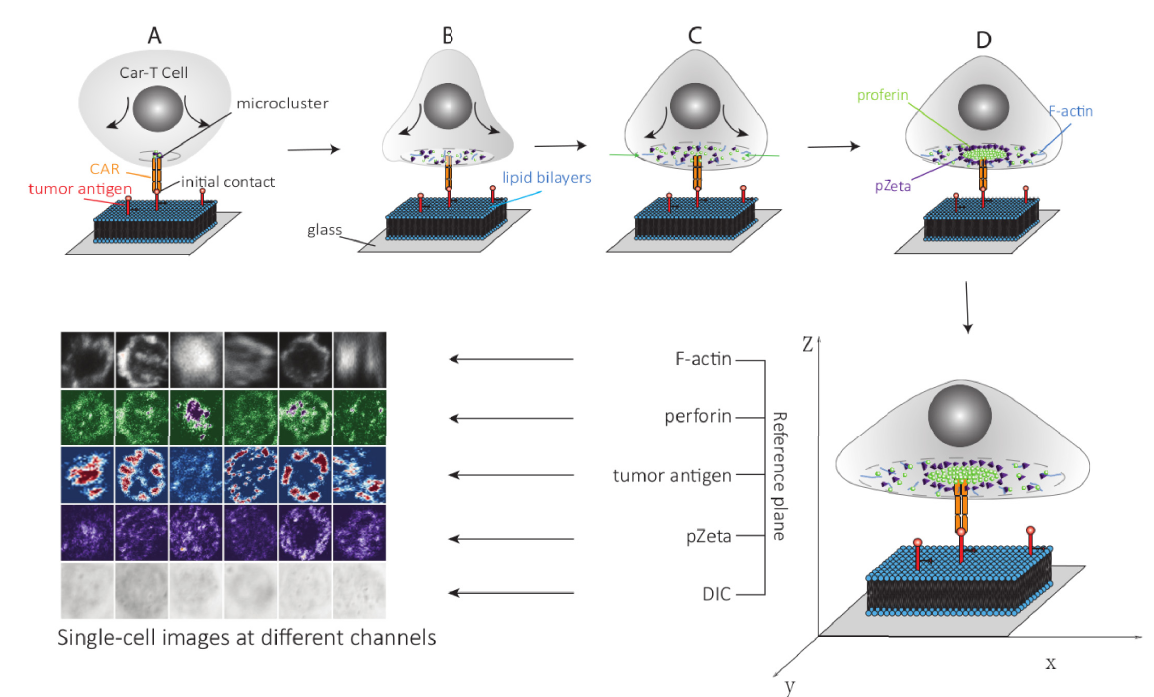
Fig 2. The model shows the process of perforin and pZeta cluster formation, and accumulation of F-actin formation after the initial contact of the CAR-T and planar lipid bilayer. (A) At the initial contact of the CAR with the tumor antigen, micro clusters are formed around the receptor, and the cell starts to spread. (B) The cell spread, and multiple microclusters form. (C) After the cell spread, F-actin polymerizes at the cell periphery. The perforin and pZeta are transported toward the cell center along with F-actin. (D) Perforin and pZeta populate the actin- sparse center and form a cluster. In the experiment, we labeled the different substances with different colors, and different channels of images were obtained using different lasers. We use six single-cell samples in five channels using the best Z position.